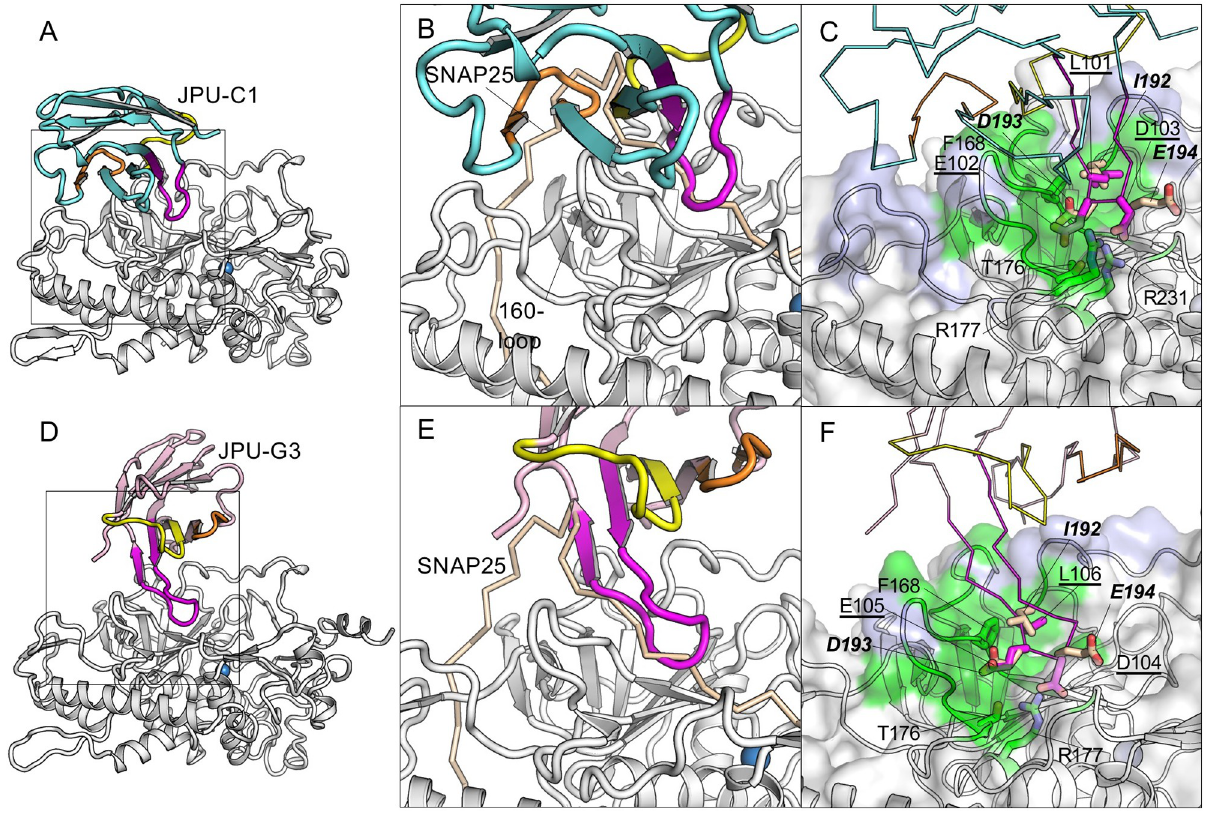
Fig 3. JPU-C1 and JPU-G3 block the interaction of SNAP25 to the anchoring site II of LC/A. (A, D) Cartoon representation of JPU-C1 (A) or JPU-G3 (D) in complex with LC/A. The framework region of JPU-C1 and JPU-G3 are colored cyan and pink respectively. The CDR1, 2, and 3 are colored yellow, orange, and magenta, respectively. (B, E) Superposition of LC/A–JPU-C1 (B) or LC/A–JPU-G3 (E) with the SNAP25(146–204)-bound LC/A (PDB ID: 1XTG). Only the VHH-bound LC/A is represented. LC/A and the long SNAP25 peptide are colored white and wheat, respectively. (C, F) The VHH residues competing with SNAP25 residues for LC/A binding are drawn as sticks. The epitopes are colored as that shown in Fig